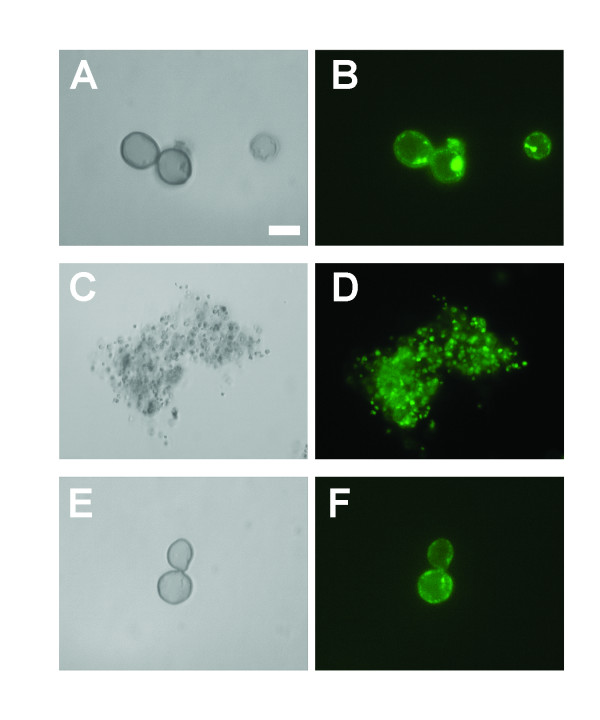
Corresponding light and immunofluorescence microscopy images of particles collected after treatment with enzymes, denaturant, and hot acid from W. dermatitidis strains [A, B] 8656, [C, D] wdpks1Δ-1, and [E, F] wdpks1Δ-1-501 grown for 10 days in YPD medium at 37°C. The particles were reacted with the melanin-binding mAb 6D2. Scale bar, 5 μm.